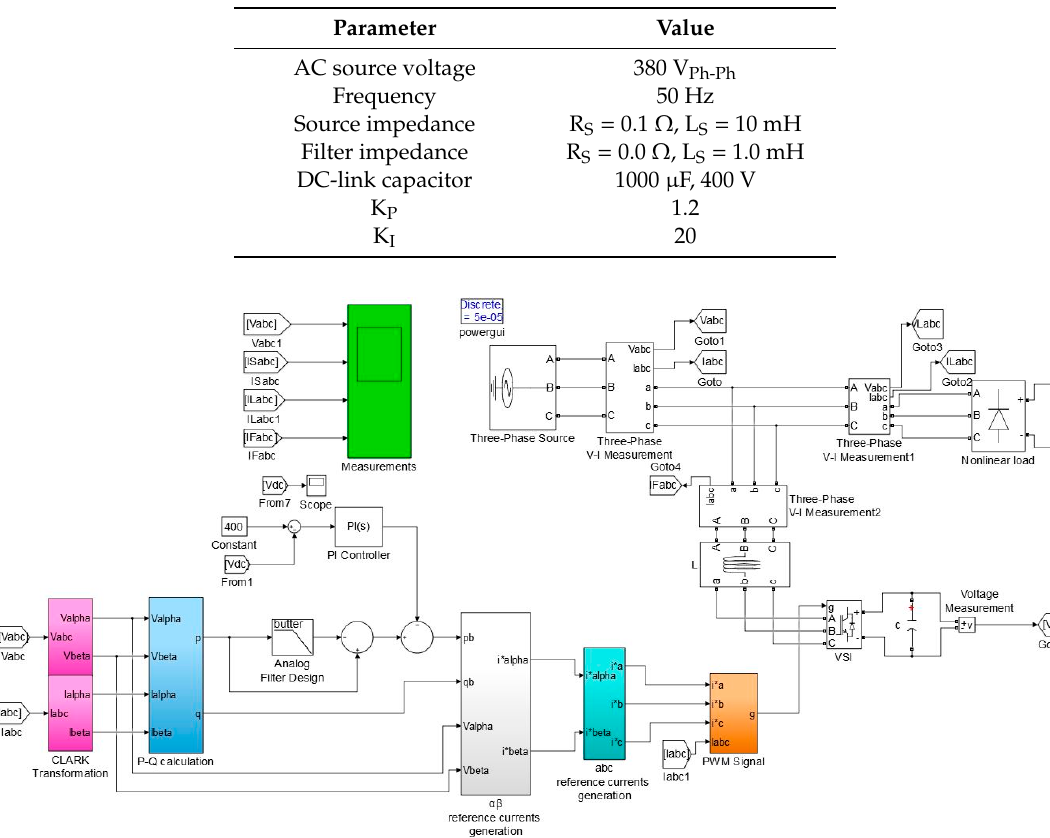
Table 1. System parameters.